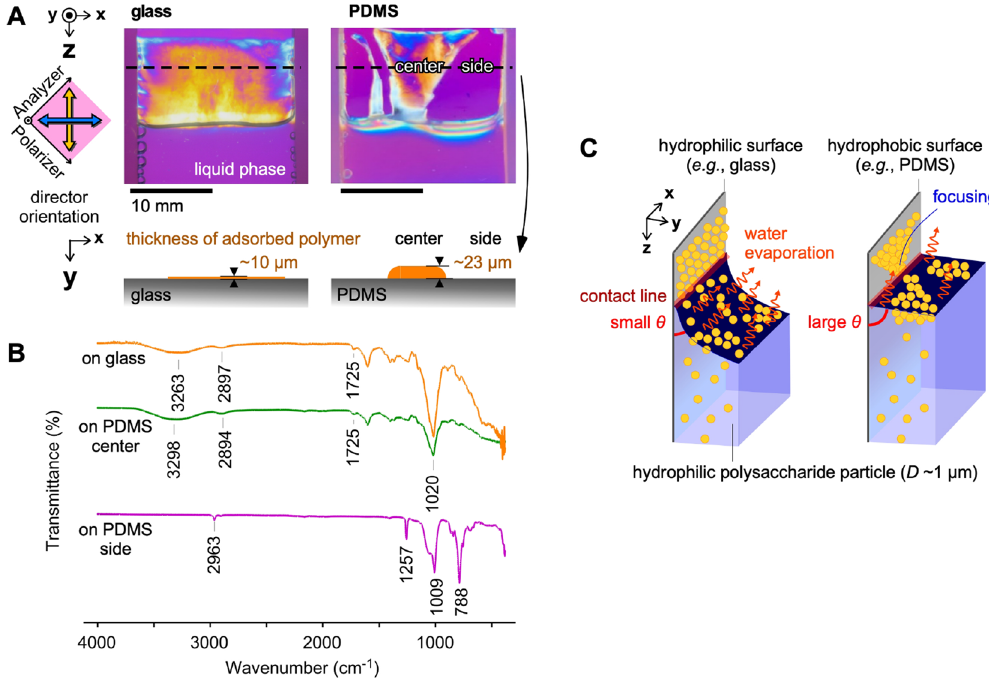
Figure 3. Evaluation of polysaccharide adsorption on glass substrates and PDMS substrates. ( A ) In-situ evaluation of adsorption under crossed-polarizers with a first-order retardation plate (λ = 530 nm) after 8-h drying at 60 °C. Inner dimensions of the cells: ( X -width, Y -thickness, Z -depth) = (20 mm, 2 mm, ~ 20 mm). Initial polymer concentration: 1.0 wt%. ( B ) IR spectrum at given area on dotted lines. ( C ) Hypothesis of adsorption of polymeric particles on hydrophilic/hydrophobic surfaces by evaporative